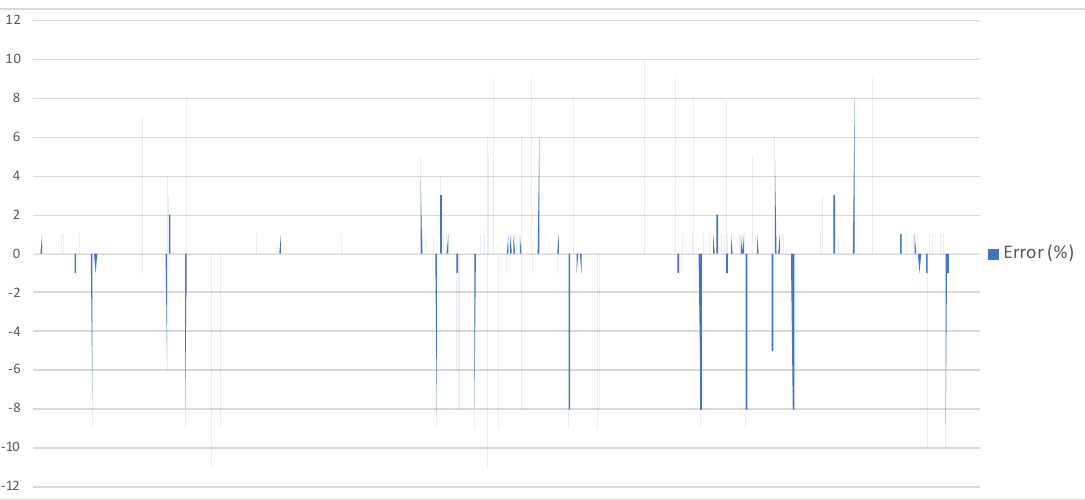
Figure 14. Collected CPU use with a 10% tolerance for a single compute node during a 24 h period.